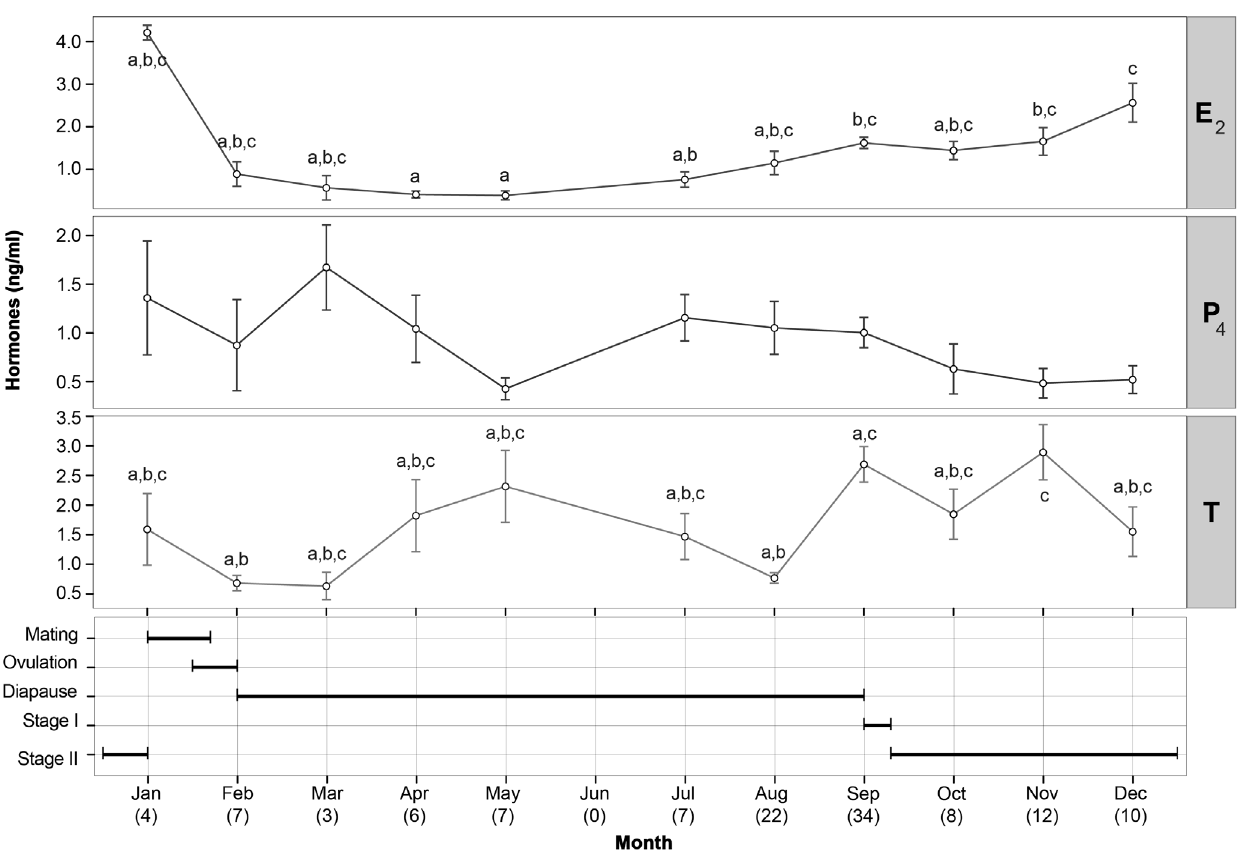
Figure 3. Seasonal variation of 17 b -estradiol (E 2 ), progesterone (P 4 ) and testosterone (T) in female Rhizoprionodontaylori . Letters depict statistical similarity using pairwise Wilcox post-hoc test. Progesterone levels were not significantly different throughout the year. The graph at the base of the figure indicates the timing of each reproductive event in females and numbers in brackets denote sample size.